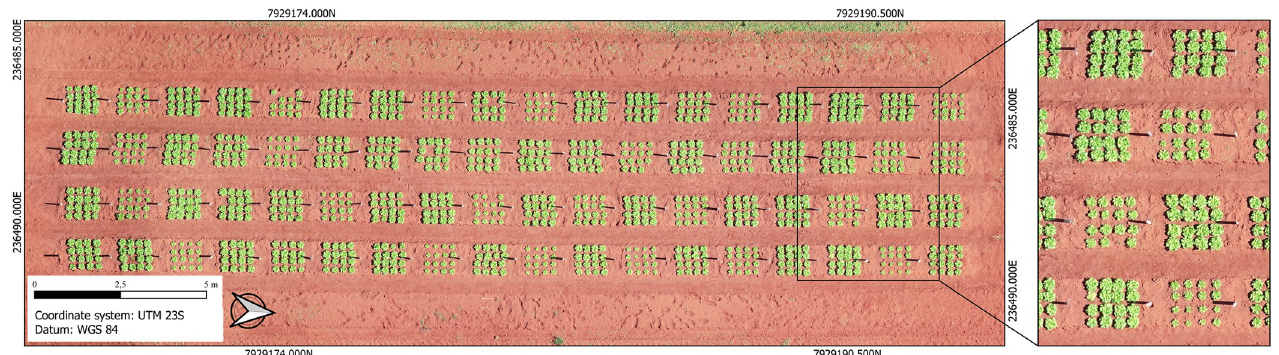
Fig 1. Orthoimage showing the aerial view of the experiment. The zoomed image on the right highlights the spatial resolution of the orthoimage generated with a GSD of 1 cm.